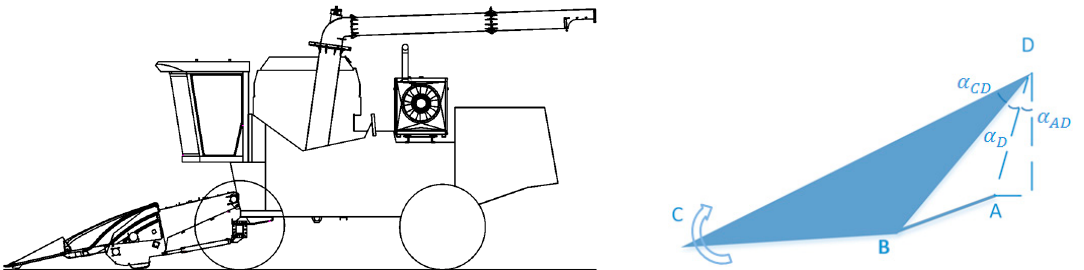
Figure 7. Movement analysis diagram of header.